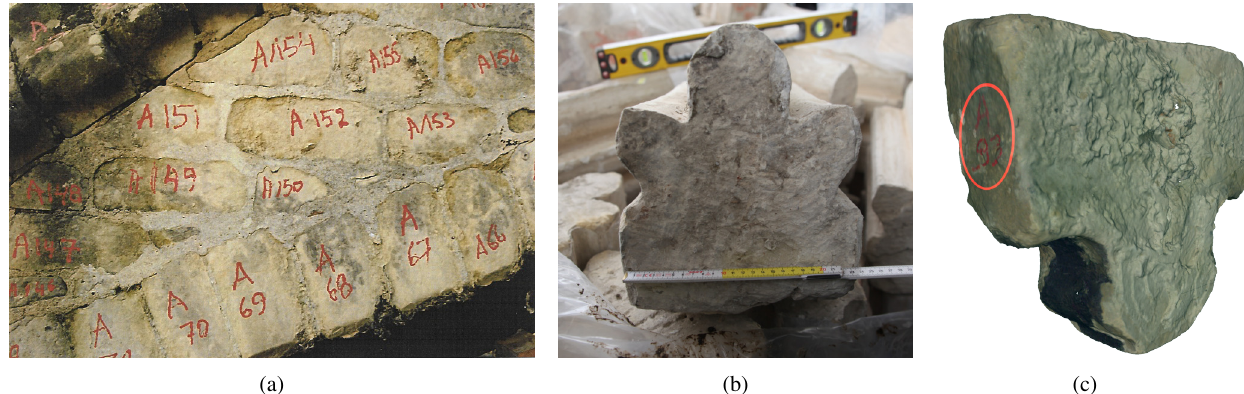
Figure 2: Examples of stones captured by a structured light hand scanner, ranging from simple to complex (a) photograph of the numbered cubic-shaped stones upon dismantlement (b) symmetrical rib vault stone (c) numbered flying buttress stone (circled left upper surface)